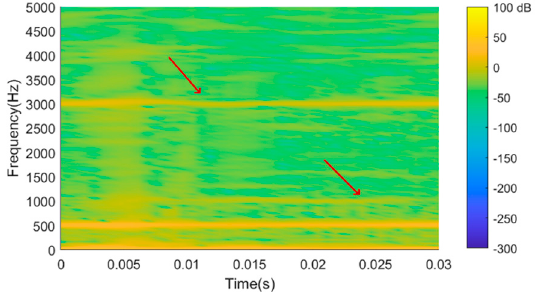
Figure 8. Time-frequency spectrogram of the measured common-mode disturbance on the battery charging cable represented by ( a ) joint TF and ( b ) WVD.